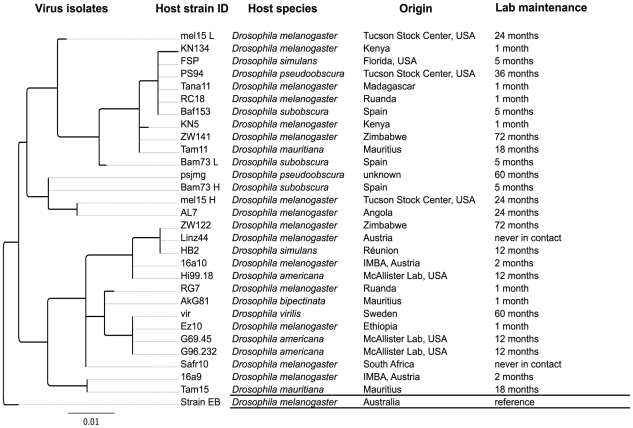
Genealogy of DCV isolates.Unrooted maximum likelihood tree showing all virus samples identified in our dataset (see File S1), including host identity (ID), host species, last known origin of the sample, and duration of laboratory maintenance in our stock collection until the time of RNA extraction. Host lines “never in contact” are wild caught lines which have never been in physical contact with lab stocks; all other lines are lab stocks. Host ID contains information about whether strains were extracted from multiply infected samples (L: low peaks; H: high peaks; see Materials and Methods and File S2).